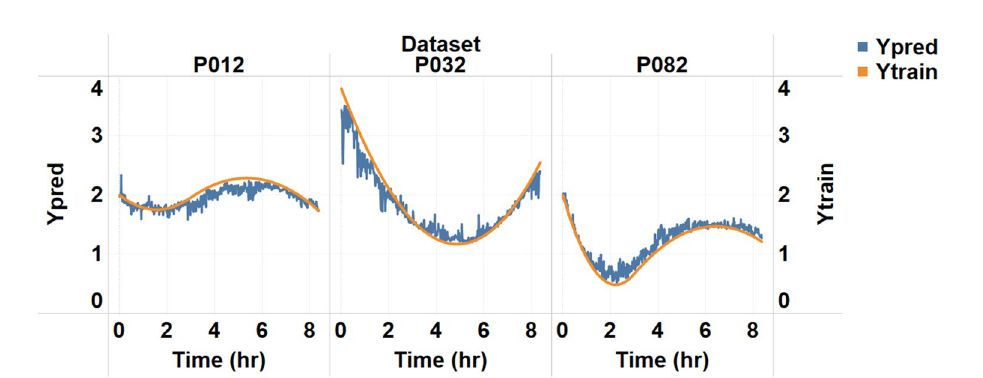
Figure 5. Results obtained on the test dataset for the three human subject datasets plotted concerning actual progression from reference